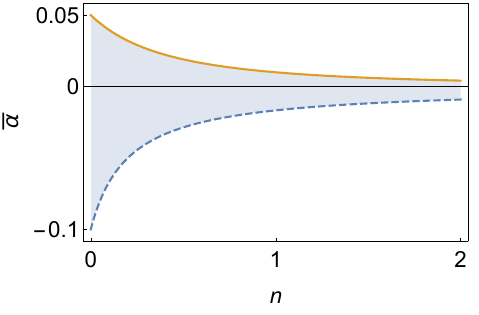
Figure 1 . The domain of existence of the solution (5.10a) in the (¯ α, n ) parameter space. The blue dashed line stands for the lower bound and is not an available curve of the parameter. The orange solid line stands for the upper bound and is an available curve of the parameter. The region between the blue dashed line and the orange solid line is an existence region of the solution for n > 0 . We only give a schematic diagram in the domain n ∈ (0 , 2) . It is worth noting that two bound lines of ¯ α will approach to zero for n → ∞ .